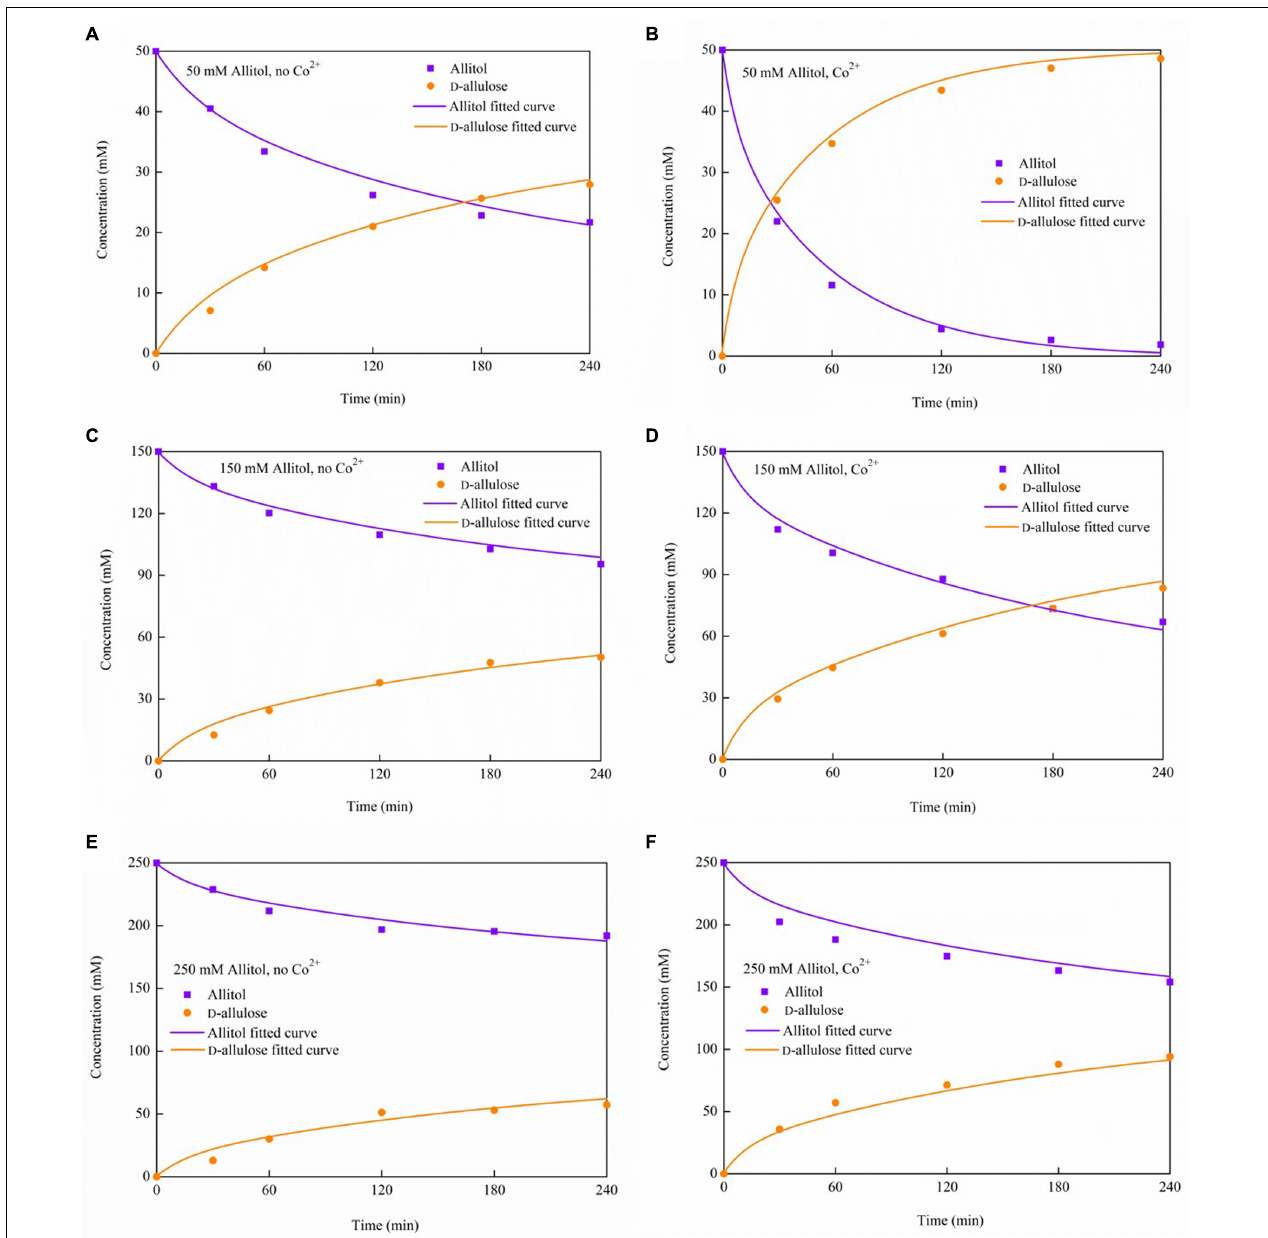
FIGURE 7 | The time courses of allitol and D -allulose concentrations during the biotransformation in the presence or absence of Co 2 + under various initial allitol concentrations. (A) 50 mM allitol, no Co 2 + ; (B) 50 mM allitol, Co 2 + ; (C) 150 mM allitol, no Co 2 + ; (D) 150 mM allitol, Co 2 + ; (E) 250 mM allitol, no Co 2 + ; and (F) 250 mM allitol, Co 2 +